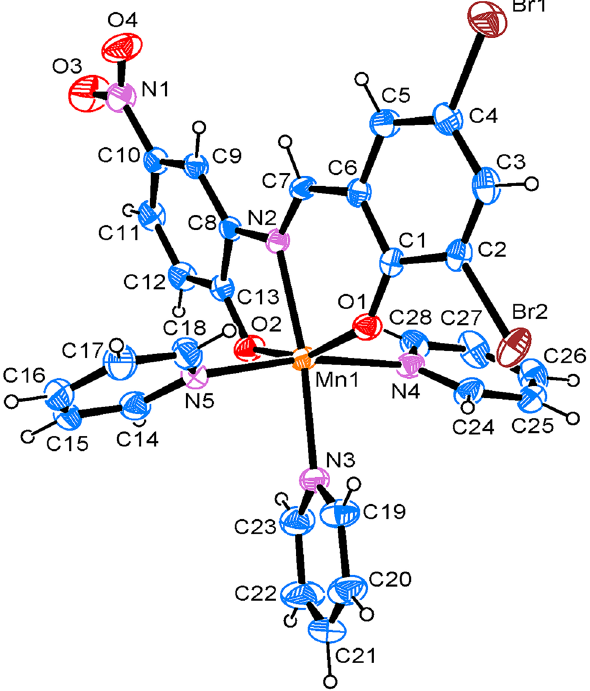
Table  : Data collection and